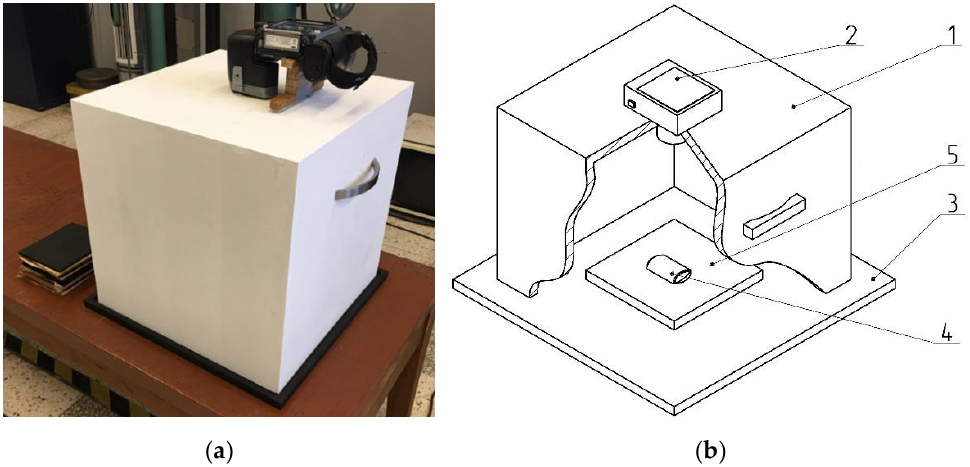
Figure 6. A specially constructed station for taking images of briquettes, which eliminates the ef- fects of external radiation: ( a ) the image [46], ( b ) the scheme: ( 1 ) cover; ( 2 ) thermal imaging camera;